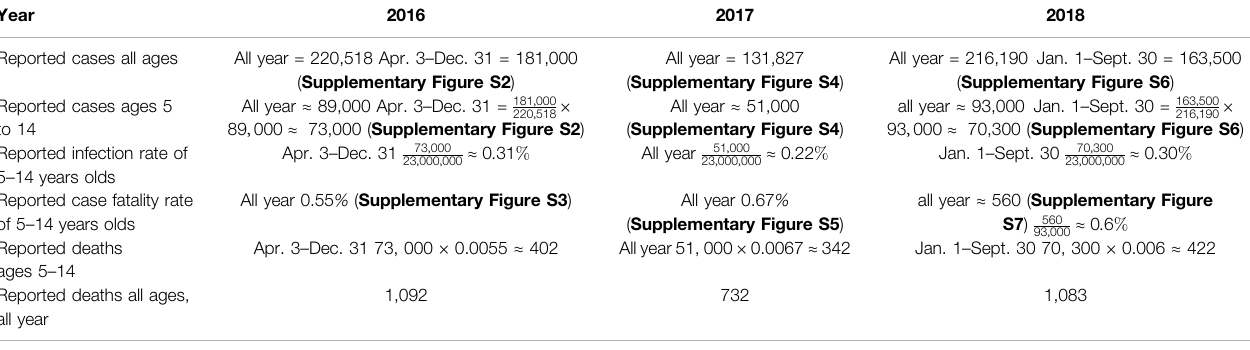
TABLE 1 | Age structured data of the dengue epidemic in years 2016, 2017, 2018. The reported data is age structured according to 5 – 9 or 10 – 14 years age brackets. The data contains no information about the effects of vaccination of this population. The data is obtained from [8] and is provided in the Supplementary Materials.